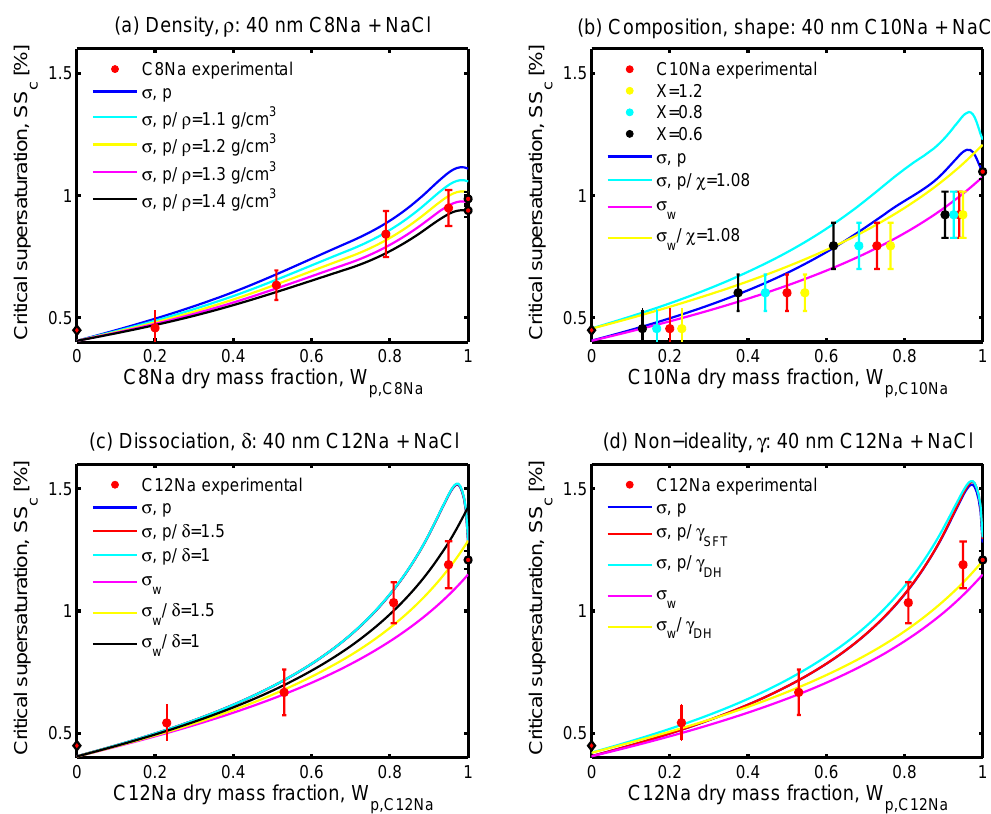
Fig. B1. Selected results of K¨ohler model sensitivity calculations, illustrating the effects for predicted critical supersaturations ( SS c [ % ] ) as functions of total dry particle surfactant mass-fractions ( W p, SFT ) of: (a) FAS bulk mass-density ρ FAS = 1 . 1 , 1 . 2 , 1 . 3 , 1 . 4gcm − 3 , (b) dry particle composition, in terms of decreasing total surfactant mass-fraction from the nominal value ( W p, SFT ), and volume-equivalent diameter ( D e p ), (c) surfactant dissociation factor δ SFT = 1 . 0 , 1 . 5, and (d) droplet solution non-ideality, in terms of decreased organic activity ( γ SFT ) and all droplet component activities predicted from Debye-H¨uckel theory ( γ DH ). Results are shown for different surfactants and surfactant property representations. See individual Sects. B1–B4 for